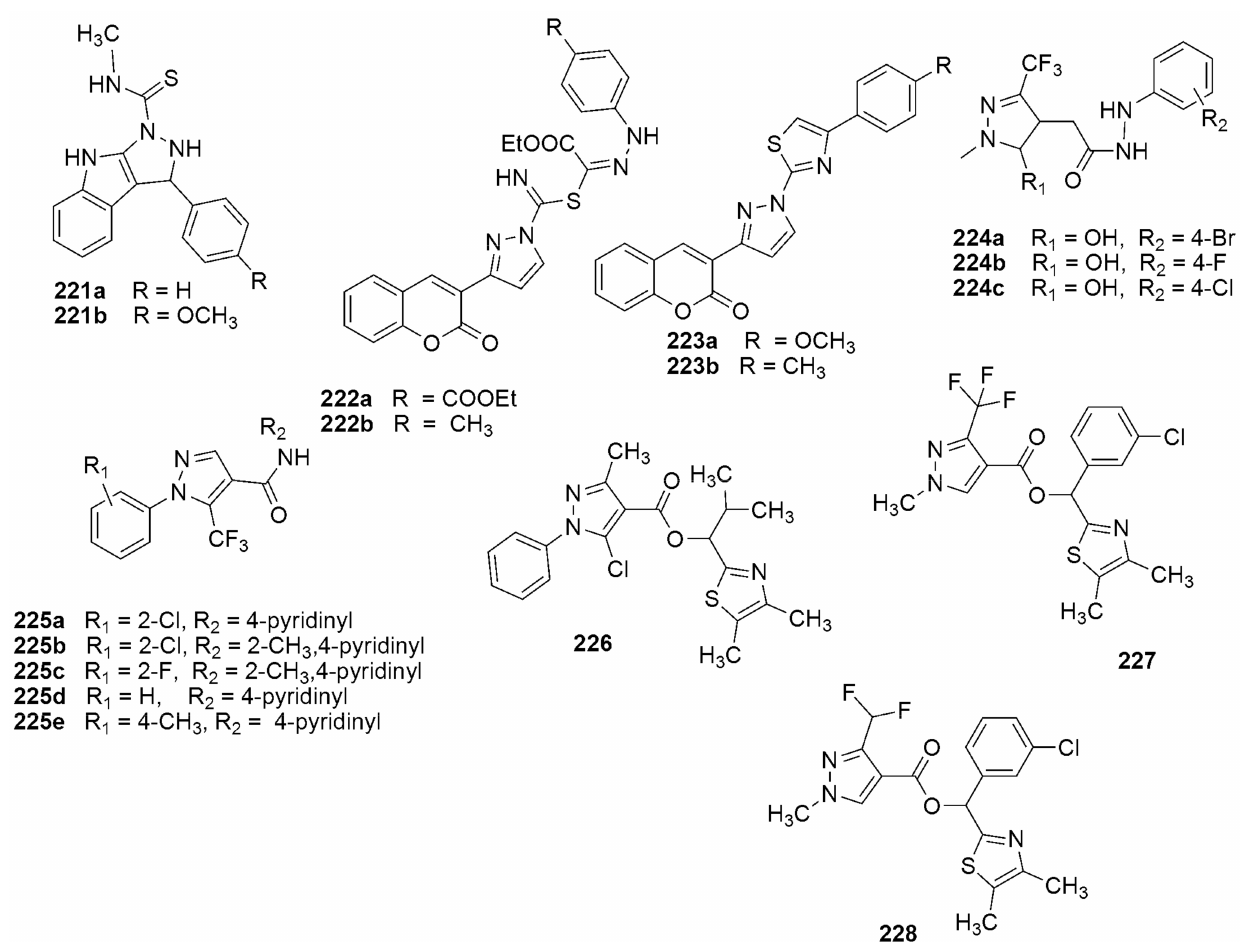
Figure 11. Structures of pyrazole derivatives as antifungal